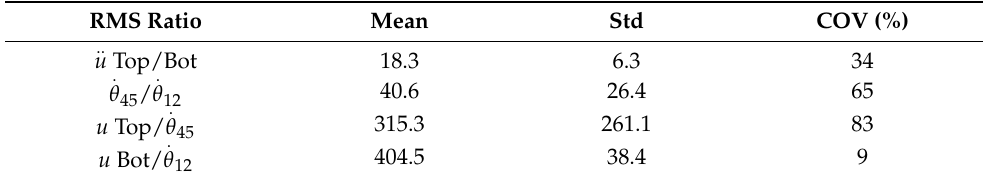
Table 2. Average ratios of root mean square (RMS) values between translation acceleration and torsion rate at the top and at the bottom of the